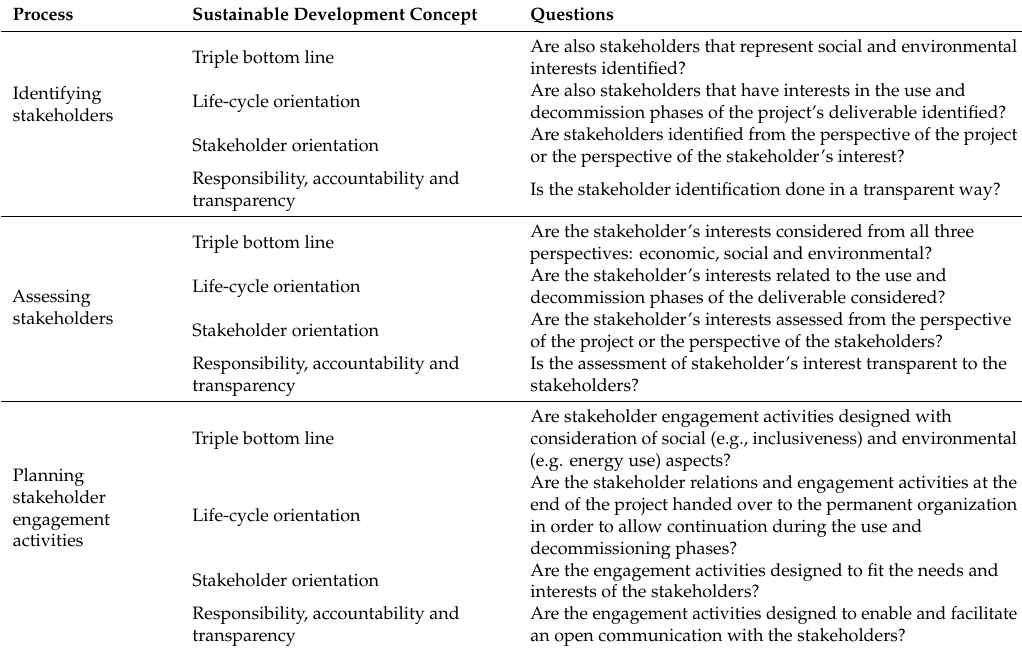
Table 4. Questions about the planning project stakeholder engagement processes derived from the concepts of sustainable